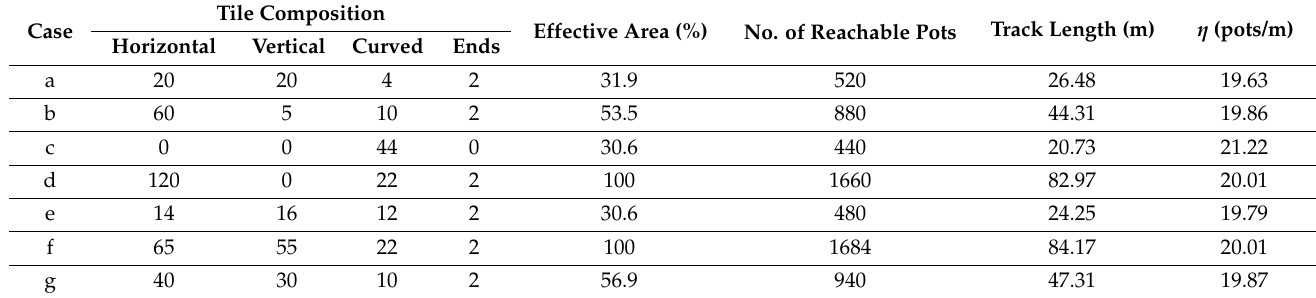
Table 1. Results of the analysis of key features of the proposed